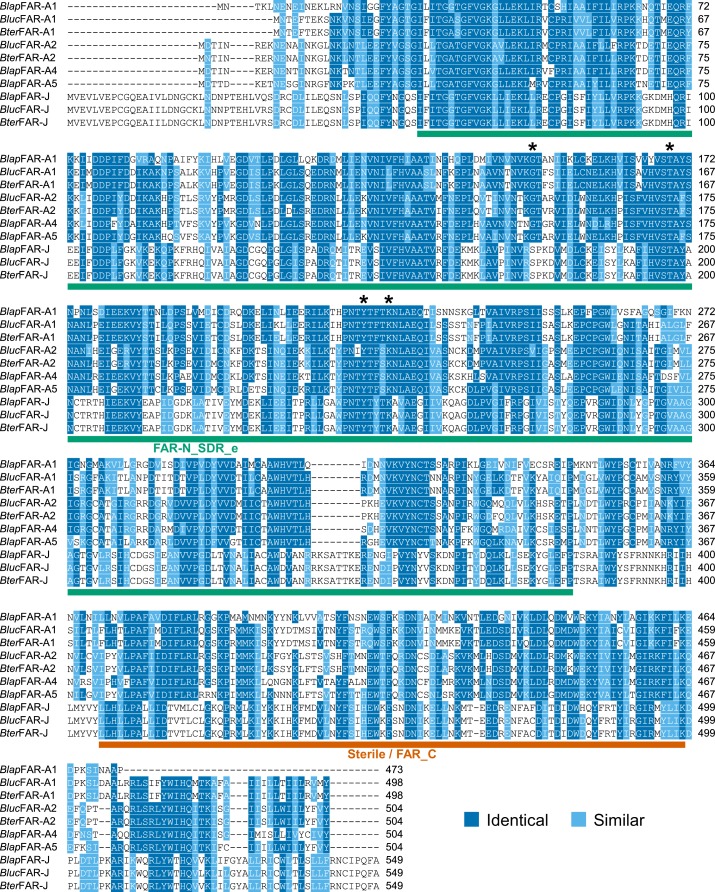
Protein sequence alignment of bumble bee FAR candidates.Identical amino acid residues are highlighted in dark blue, similar residues in light blue. The conserved domains FAR-N_SDR_e (accession number cd05236) and Sterile/FAR_C (accession numbers pfam03015 and cd09071) from Conserved Domain Database are underlined. The residues forming putative active site are marked with an asterisk. The alignment was generatedusing Clustal Omega (https://www.ebi.ac.uk/Tools/msa/clustalo/) tool using similarity groups: G, AVLI, FYW, CM, ST, KRH, DENQ.